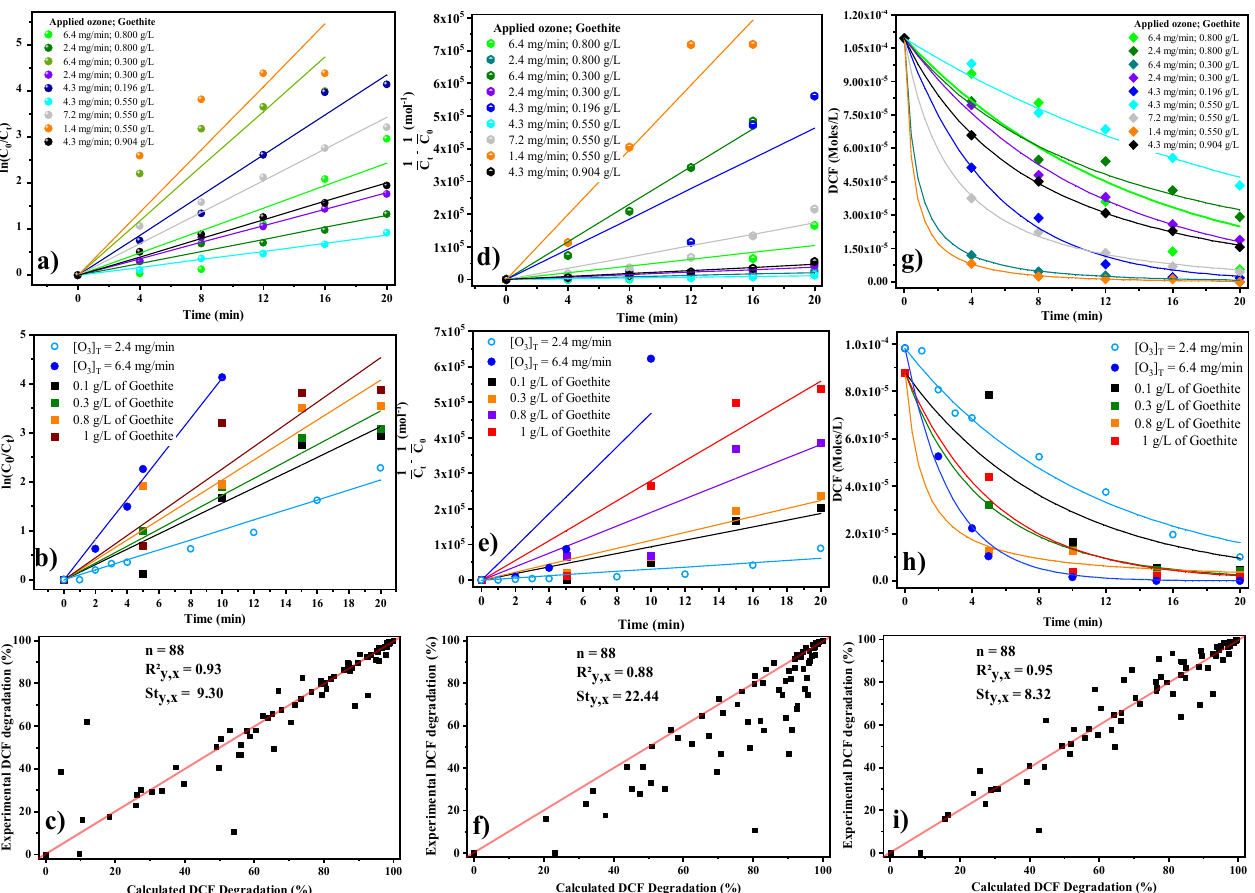
Figure 3. For ozonation and catalytic ozonation: prediction of experimental data using pseudo-first-order ( a , b ), second-order models ( d , e ), MORM ( d , g,h ), and correlation with calculated data ( c , f , i ).